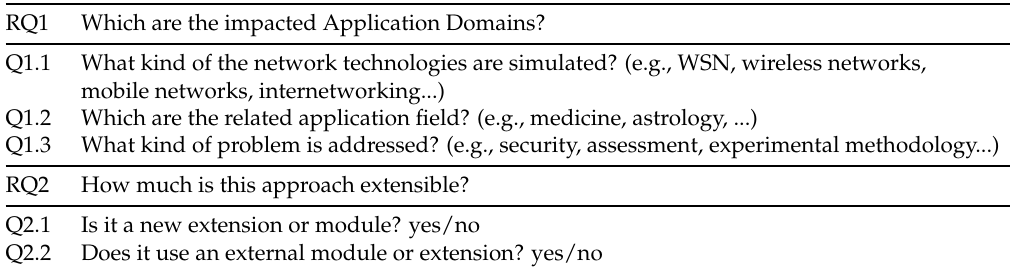
Table 8. Data Extraction Form—part